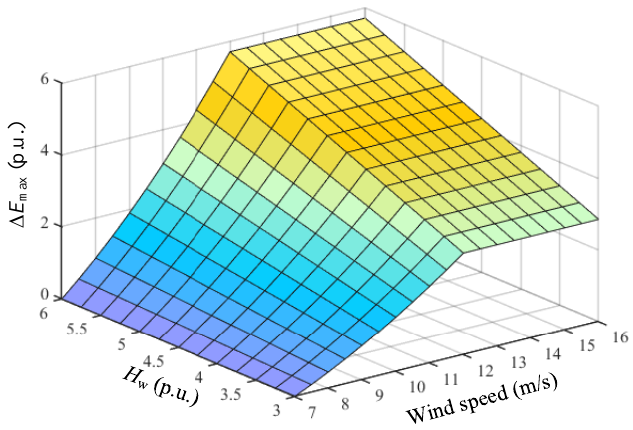
Figure 4. Maximum rotor kinetic energy of the wind turbine.